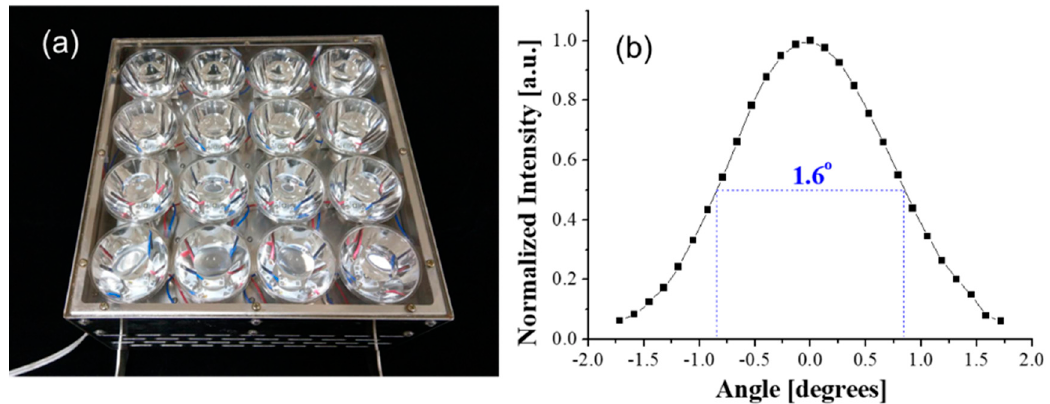
Figure 12. ( a ) Spot light module and ( b ) measured intensity distribution.